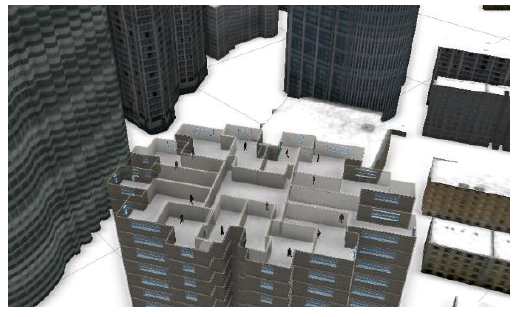
Figure 2. 3D Internal Model of the Target